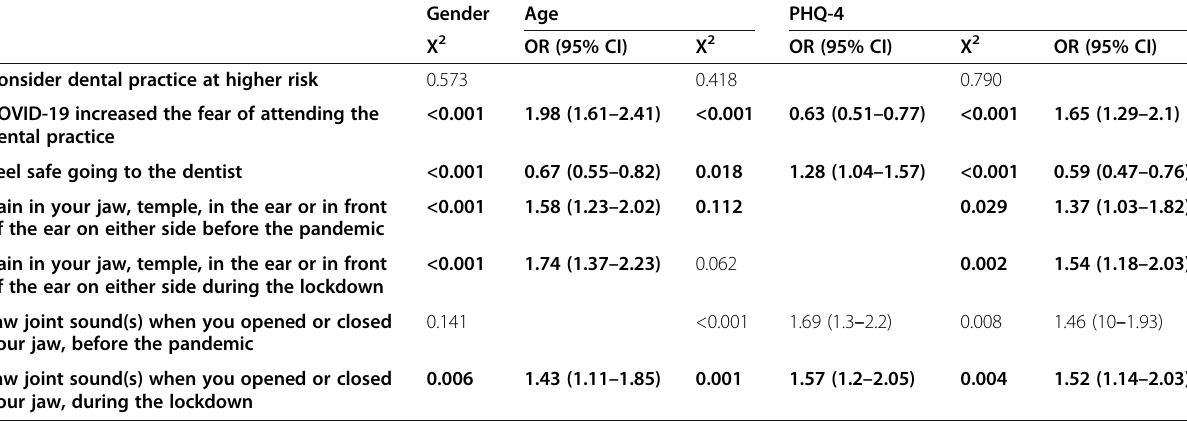
Table 6 Chi-square test and regression analysis for question related to anxiety toward attending the dental practice, presence of TMD symptoms, and gender, age, and PHQ-4 Gender Age